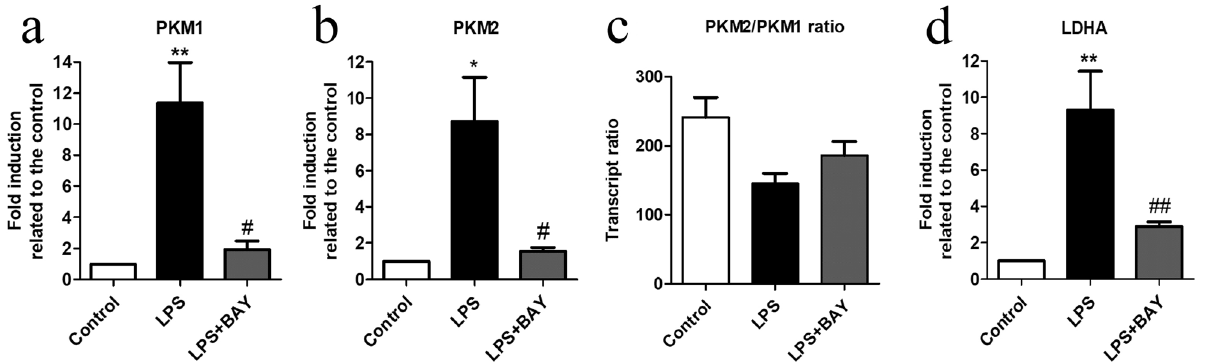
Figure 4. BAY11-7042, an inhibitor of NFκB, reduced PKM1, PKM2 and LDHA transcripts in microglial cells treated with LPS. The mRNA expression for (a) PKM1, (b) PKM2 and (d) LDHA was determined by qPCR in microglia cultures. Cells were preincubated with BAY11-7042 (2 μM) for 1 h and then LPS (10 ng/ml) was added for further 24 h. The expression of 36B4 was used as a housekeeping gene to normalize the data. Results represent the mean ± SEM of fold induction related to the control of the target gene transcript expression and 36B4 transcript expression of at least n ≥ 3 independent experiments. ANOVA revealed significant treatment effects on the transcription of (a) PKM1 [F (2, 10) = 11.3, p < 0.01]; (b) PKM2 [F(2, 10) = 7.9, p < 0.01] and (c) LDHA [F(2, 6) = 27.8, p < 0.001]. (d) Changes of PKM2/PKM1 ratio were not statistically significant. Bonferroni